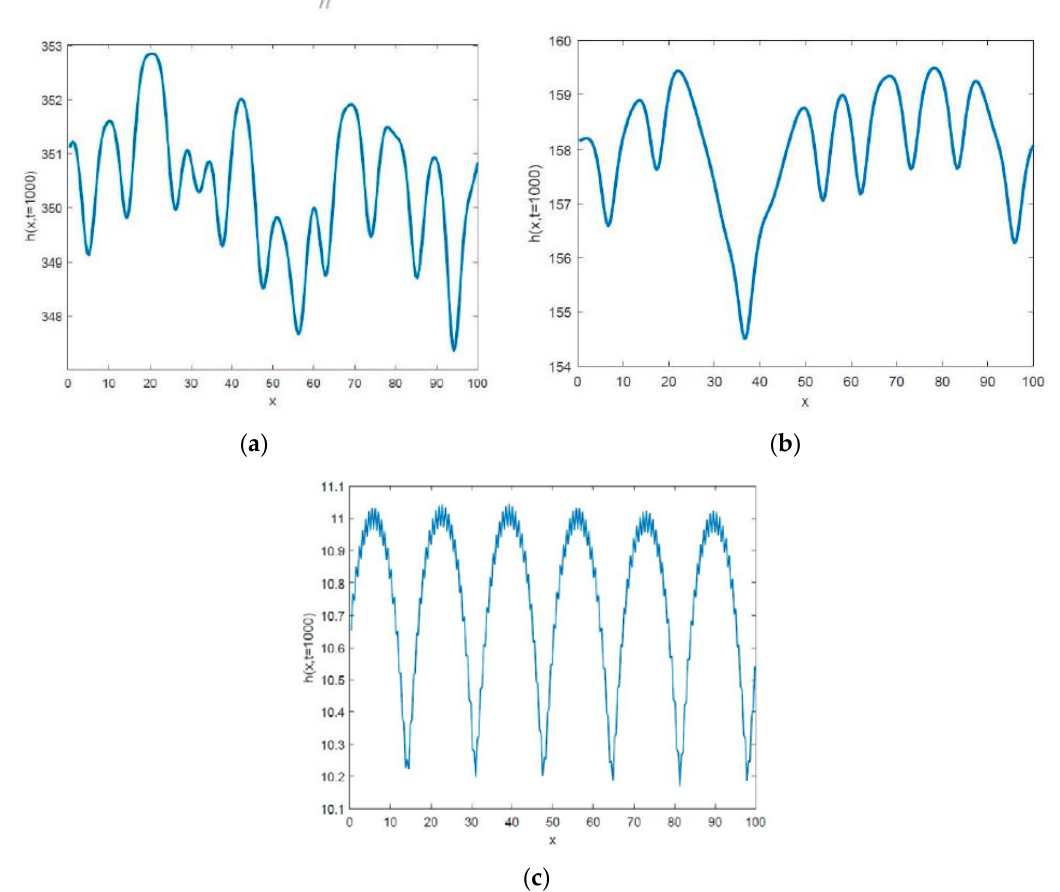
Figure 2. The height profile for time t = 1000 and for di ff erent values of parameter r ( a ) r = 0.01 ( b ) r = 0.5 ( c ) r =